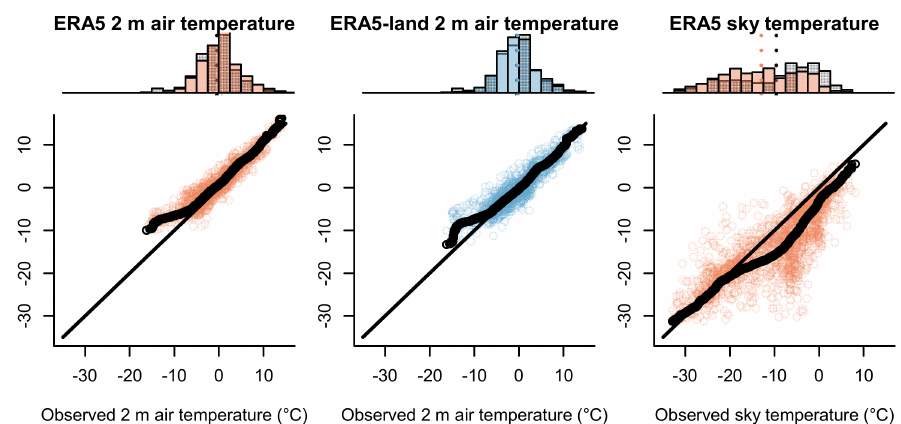
Figure 9. Observed outdoor temperature and sky temperature (computed from longwave radiation) at the Holzkirchen site compared to the ERA5 reanalysis for the period 7 December 2018 to 28 February 2019.